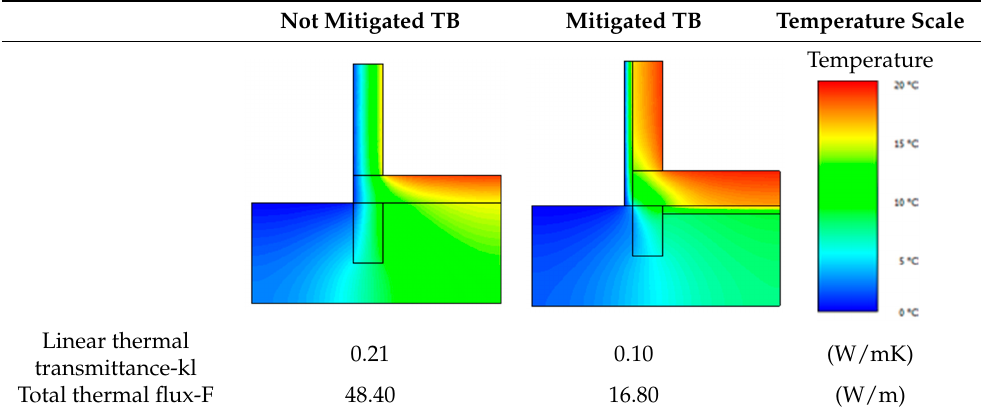
Table 13. GF Thermal bridges.